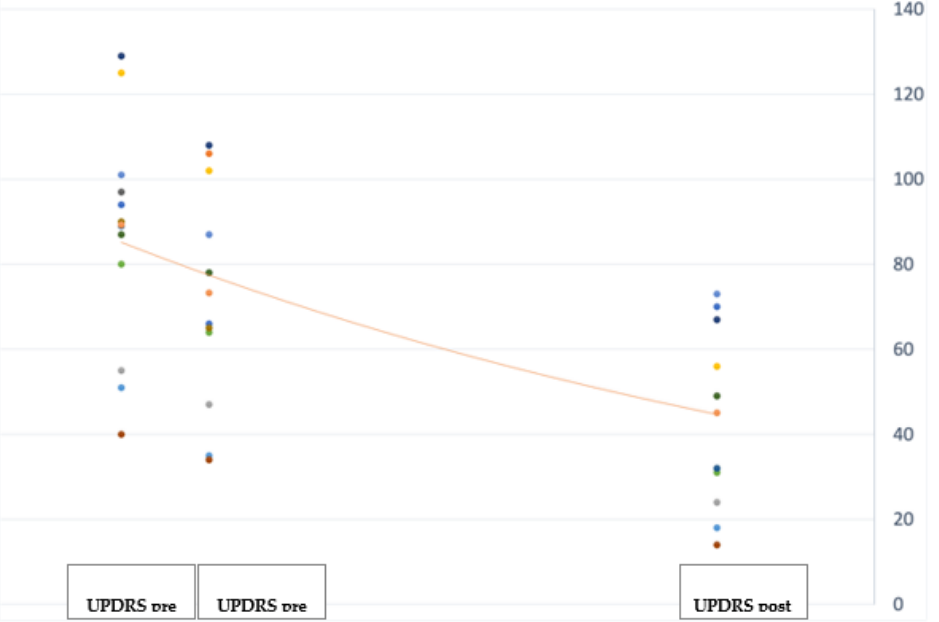
Figure 2. Jittered scattered plot showing the preoperative ( left ) and postoperative ( right ) Hamilton Anxiety Rating Scale values of the 14 patients in the study. The difference between the preoperative ONmed and postoperative ONstim showed a p -value = 0.041. The line shows the negative (improv- ing) trend of the values.